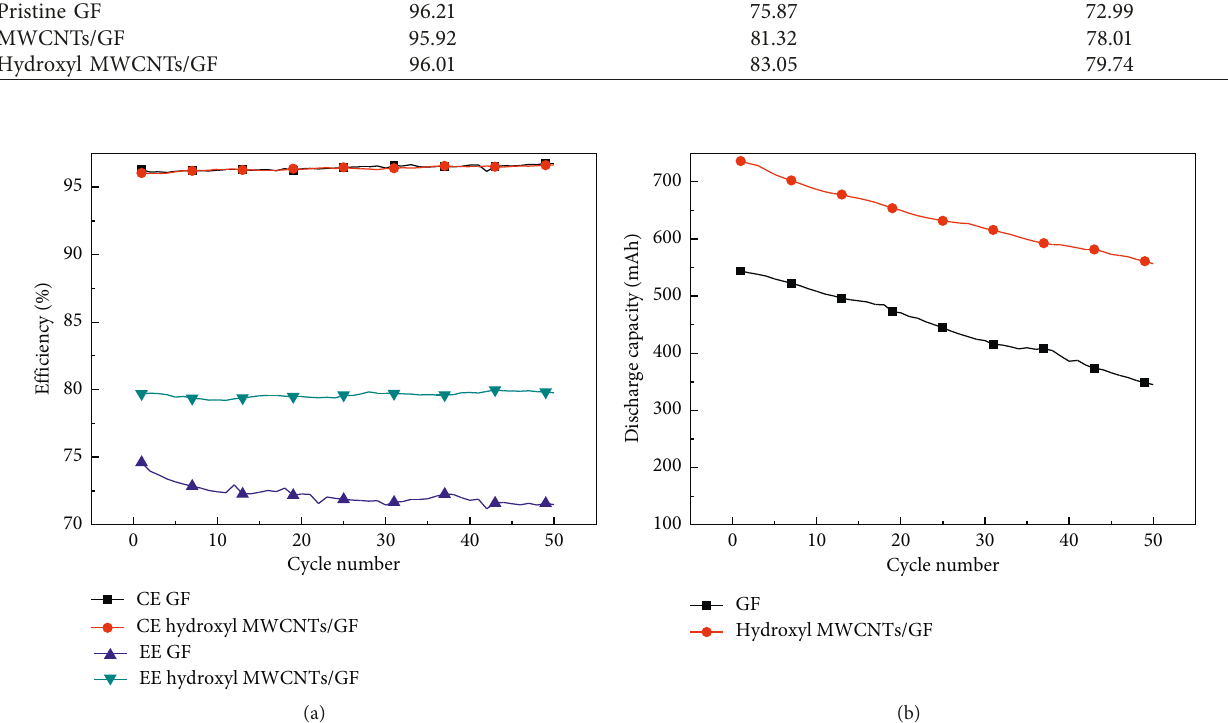
Figure 8: Variation of cell efficiency (a) and discharge capacity (b) after 50 cycles of charge-discharge tests for cells equipped with GF and hydroxyl MWCNTs/GF